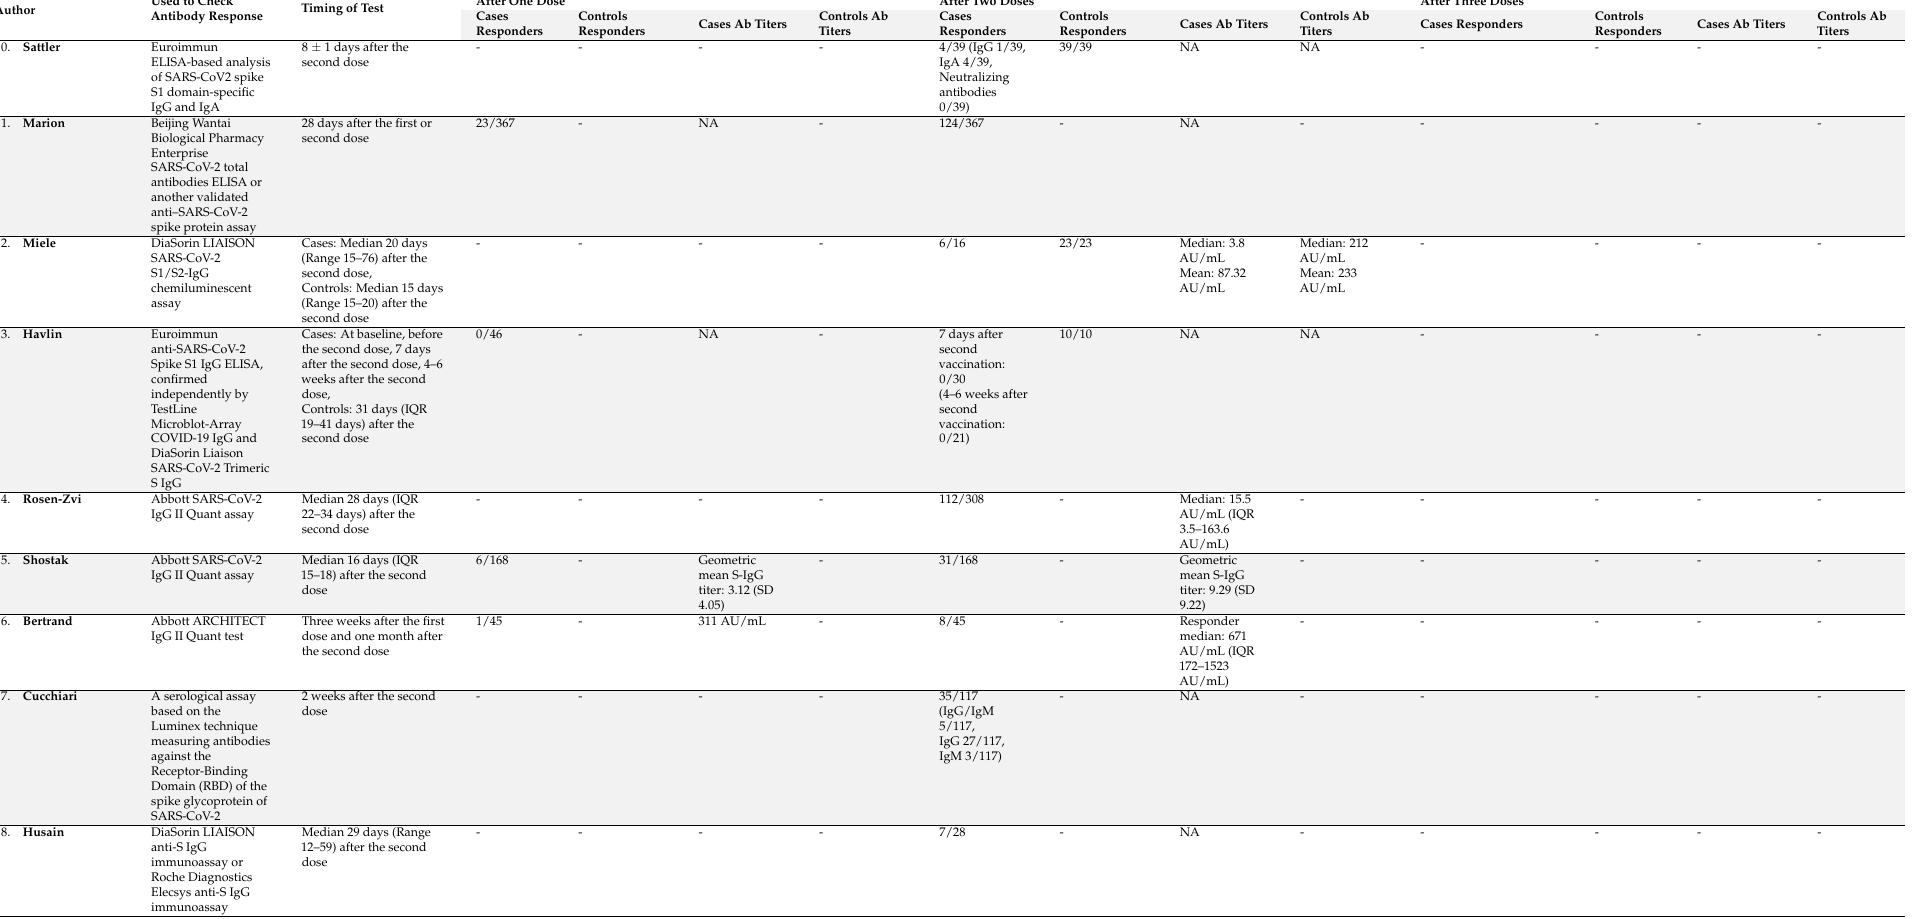
Median: 3.8 AU/mL Mean: 87.32 AU/mL